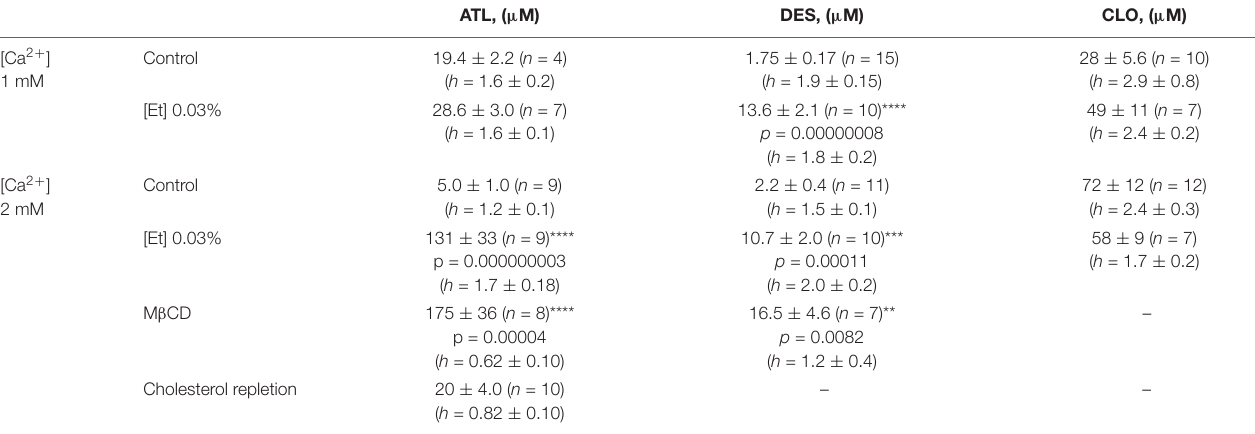
TABLE 1 | Comparison of IC 50 values for inhibition by tricyclic antidepressants of NMDAR currents. ATL, ( µ M) DES, ( µ M) CLO, ( µ M)